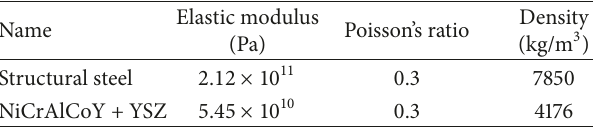
Table 2: Material parameters of TCS and hard coating. Figure 2: The theoretical model of TCS with hard